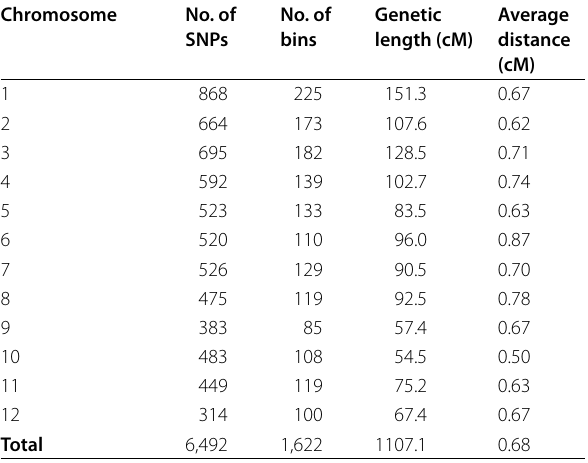
Table 1 Number of polymorphic SNPs on different chromosomes